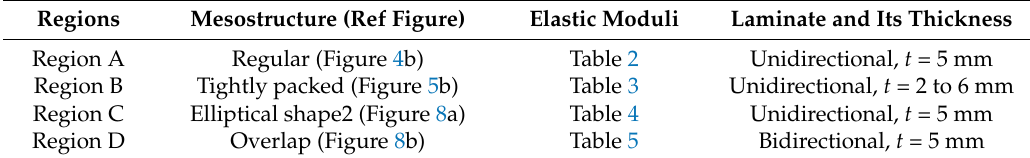
Table 8. Mesostructures in a connecting component and their elastic